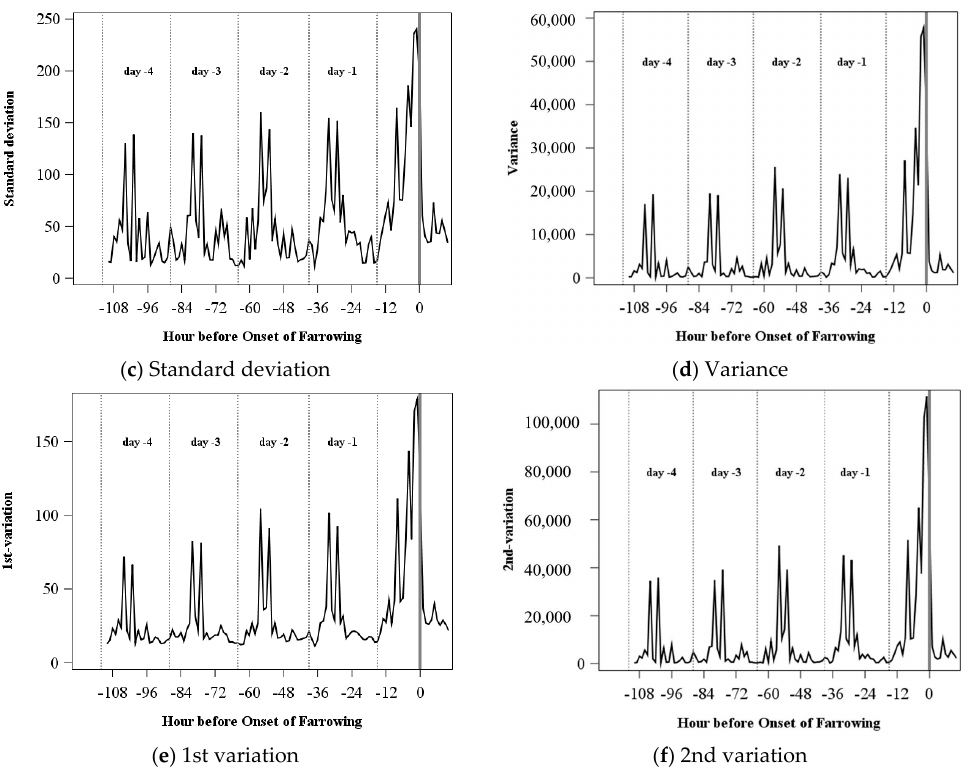
Figure 2. Exemplary distribution characteristics for one sow from Day − 4 until onset of farrowing at 2:11 p.m. on Day 0 (corresponds to Hour 0 in the figures) for one sow.